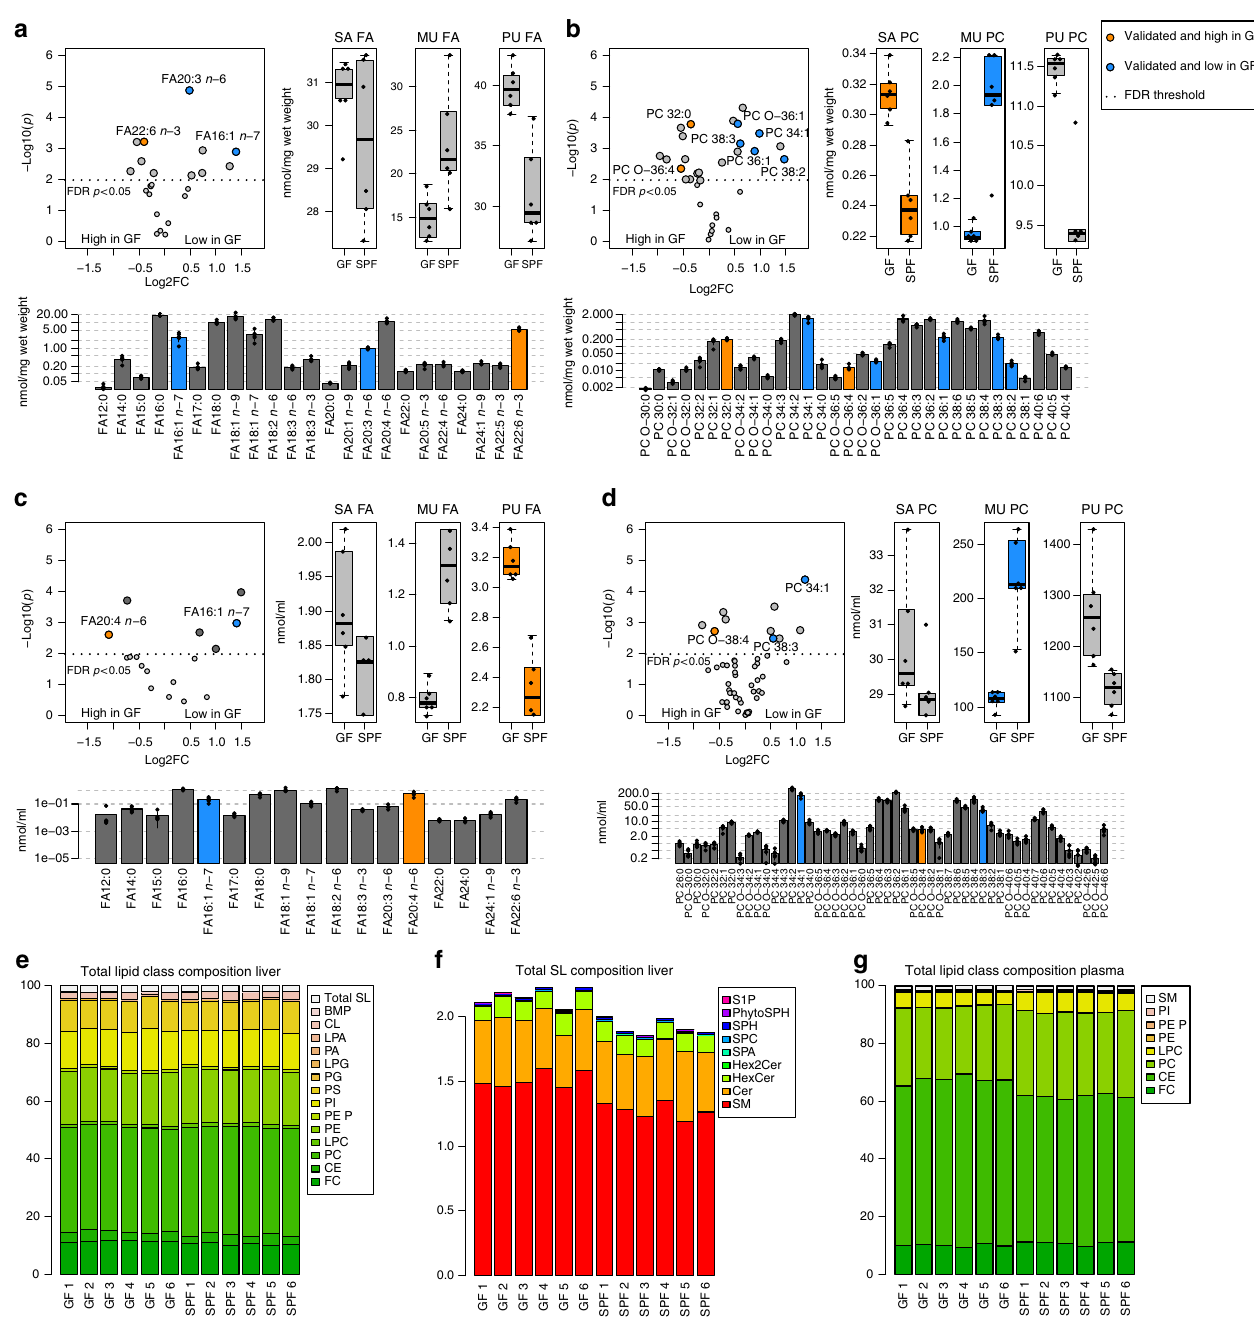
Fig. 2 Quantitative lipidome analyses of liver and plasma from GF and SPF mice. Data from experiment 1 are shown ( n = 6/6). Candidates veri fi ed in experiment 2 (SPF: n = 14; GF: n = 12) are displayed in blue (high in SPF) or orange (high in GF). a Total fatty acids (FA) in liver. b PC species in liver. c Total FA in plasma. d PC species in plasma. a – d Volcano plots: signi fi cance and log 2 fold change in individual lipid species; boxplots: concentrations of saturated (SA), monounsaturated (MU), and polyunsaturated (PU) lipid species in GF and SPF mice; barplots: molecular lipid species pro fi le of GF animals. In boxplots the thick lines represent the medians, the upper and lower lines of the boxes show the 25 and 75% quartiles and the whiskers are 1.5 times the interquartile range of the data. Error bars in the bar plots show the standard deviation. e Lipid class composition of liver samples, experiment 1. f Sphingolipid composition of liver samples, experiment 1. g Lipid class composition of plasma, experiment 1. GF: germfree, PC: phosphatidylcholine (diacyl), PC: O phosphatidylcholine (alkyl-acyl), SPF: speci fi c pathogen-free, for other abbreviations, see Table